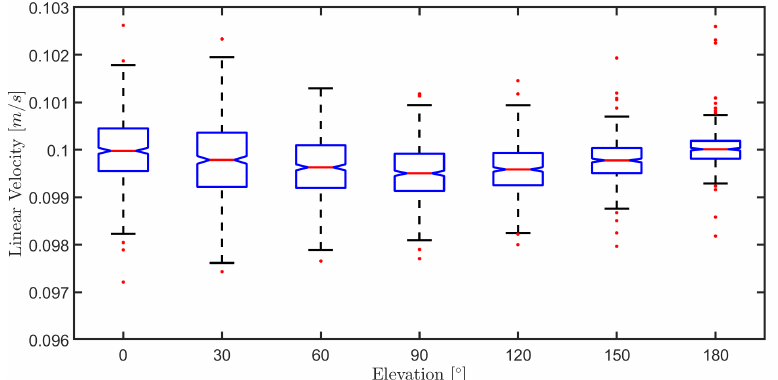
Figure 19. Boxplot of the linear velocities in the elevation variation experiment.